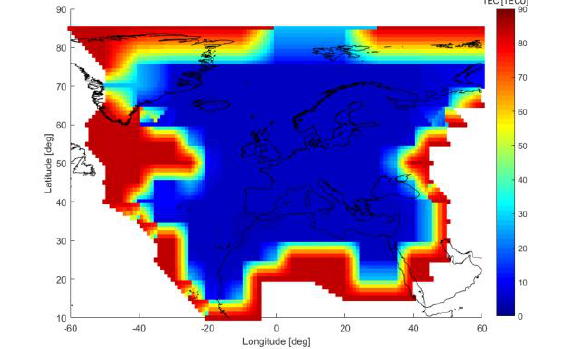
Figure 5. Interpolated EGNOS RMS map at 13:45 20/08/18